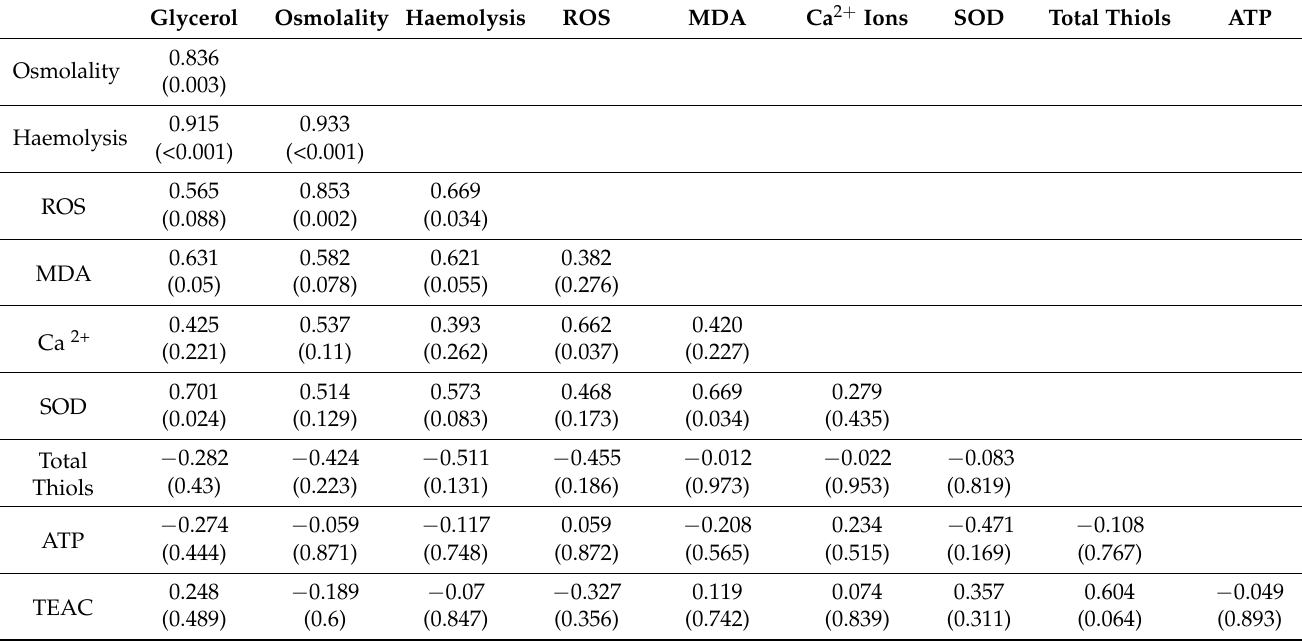
Table 3. Pearson correlation coefficients between intracellular glycerol, oxidative stress markers, and hemolisys. p values are shown within parentheses.